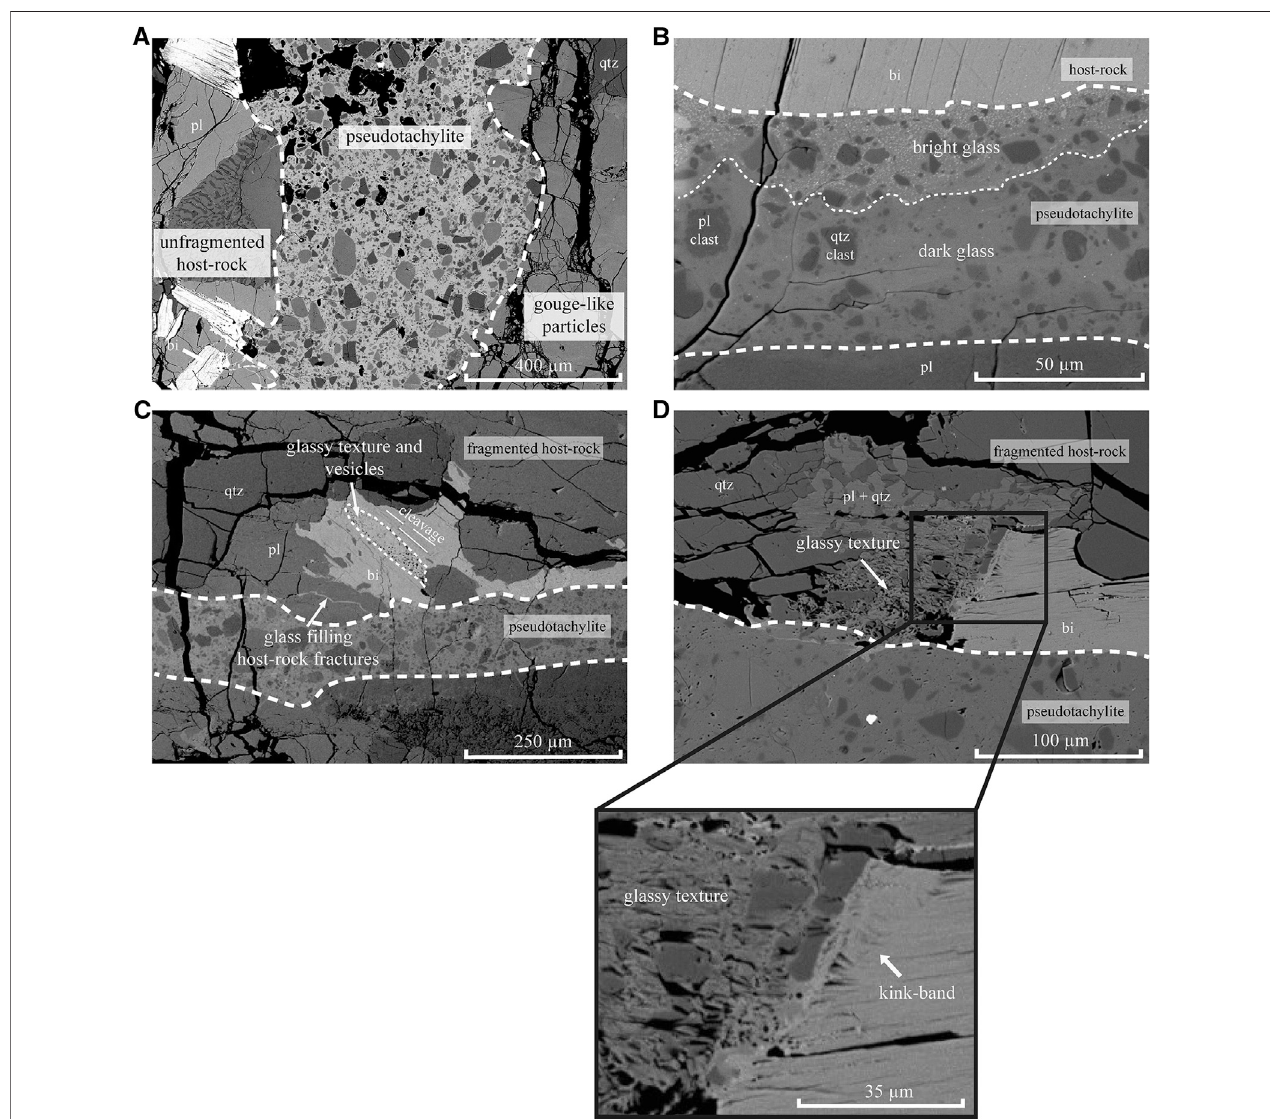
FIGURE 6 | BSE images of the tonalite-hosted specimen. (A) General view of pseudotachylite surrounded by fragmented host rock (right) and unfragmented host rock in sharp contact with the pseudotachylite (left); (B) enlargement of pseudotachylite – biotite contact, illustrating the glass heterogeneity, with brighter glass close to biotite; (C) glassy texture and vesicles along biotite cleavage and evidence of melt percolation around plagioclase; (D) melting texture of plagioclase within a primary symplectite of plagioclase and quartz. Inter-grown quartz is preserved compared to the surrounding plagioclase. Kink-bands are present in biotite.